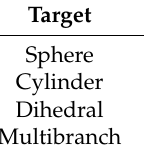
Figure 14. Classification result of four types of targets. ( a ) Sphere. ( b ) Cylinder. ( c ) Dihedral. ( d ) Multibranch. Table 2. Accuracy of particle center supported plane.